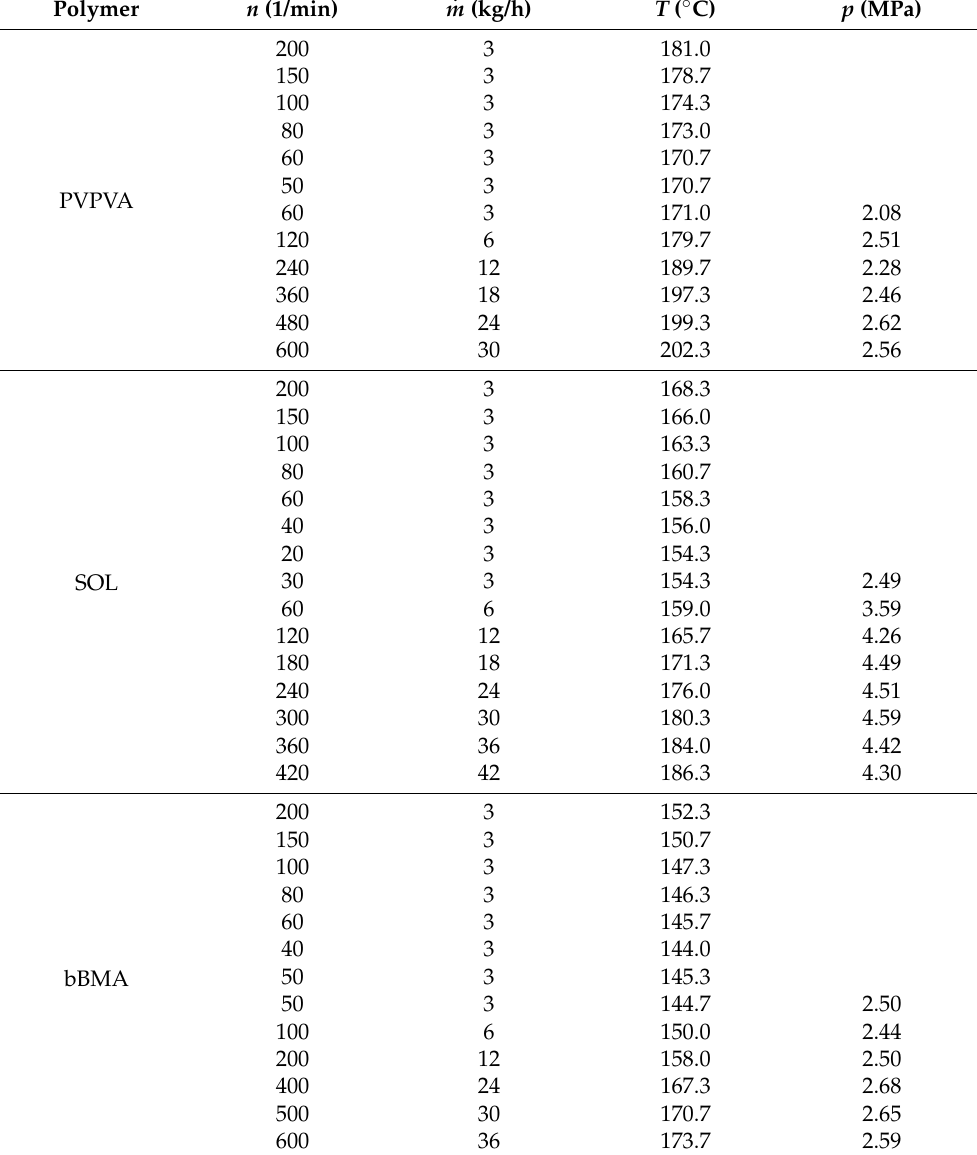
Table A1. Experimental data from Scale-Independent Optimization Strategy (no pressure data for the first phase—since no thermal